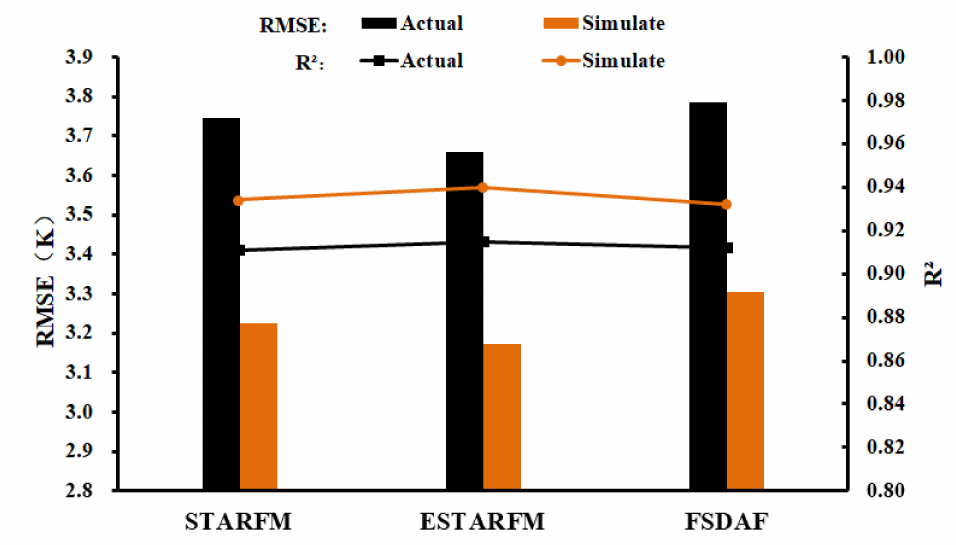
Figure 11. Comparison of simulation and actual fusion results over